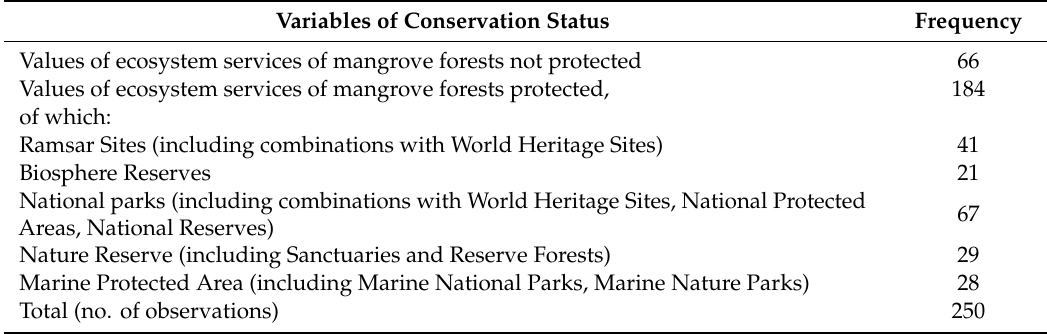
Table 2. Selected descriptive statistics of the papers and studies collected for the database referring to the conservation status of the considered mangrove forests. Variables of Conservation